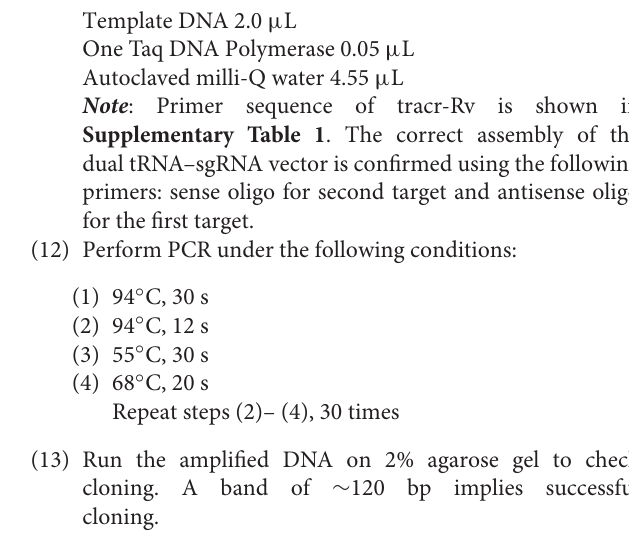
Supplementary Table 1 . The correct assembly of